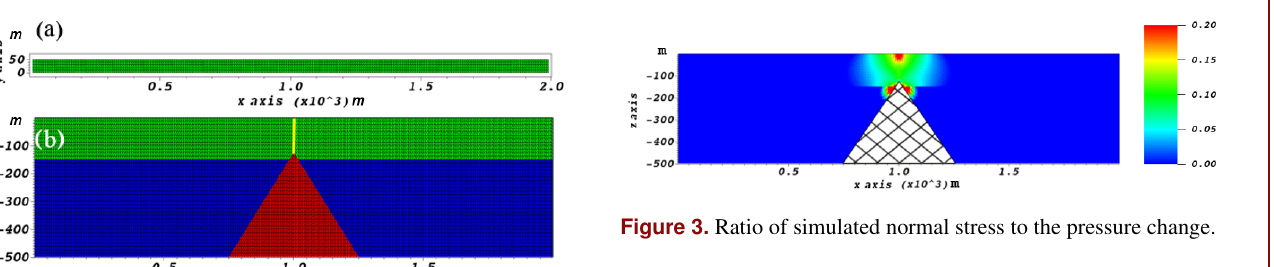
3 Software and its application